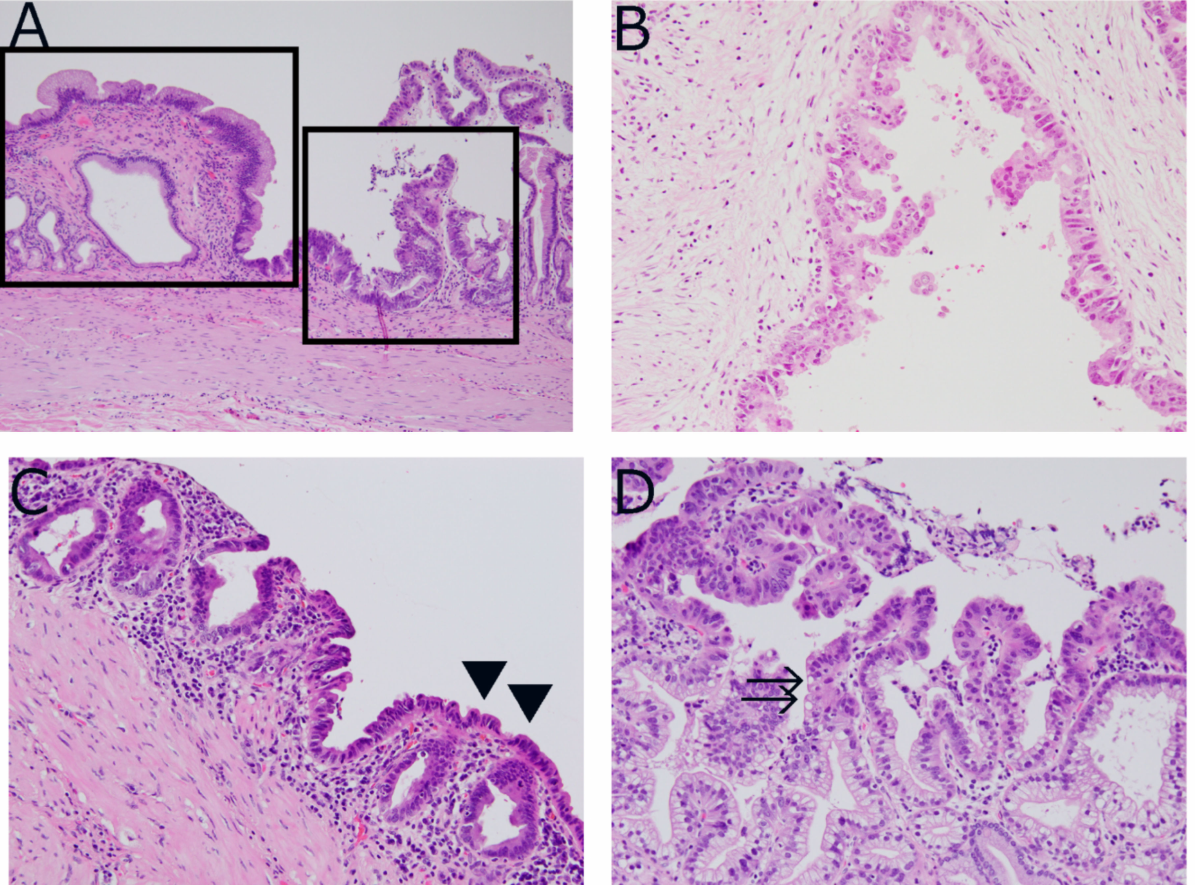
Figure 3. Pathology of biliary intraepithelial neoplasia (BilIN) by hematoxylin and eosin staining. ( A ) Low-grade BilIN component (left box) seen next to high-grade BilIN component (right box). ( B ) High-grade BilIN lesion with pseudopapillary eosinophilic epithelium with tufting and atypia pattern. ( C ) High-grade BilIN with adenoma-like pattern (arrowheads). ( D ) High-grade BilIN with micropapillary pattern. Scattered goblet cells are seen